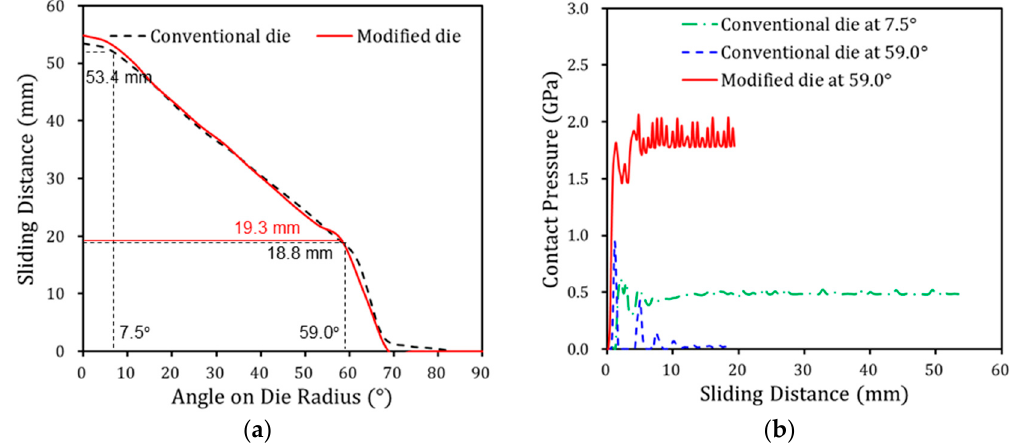
Figure 17. Contact behavior over the die radius: ( a ) sliding distance on the die radius and ( b ) contact history.